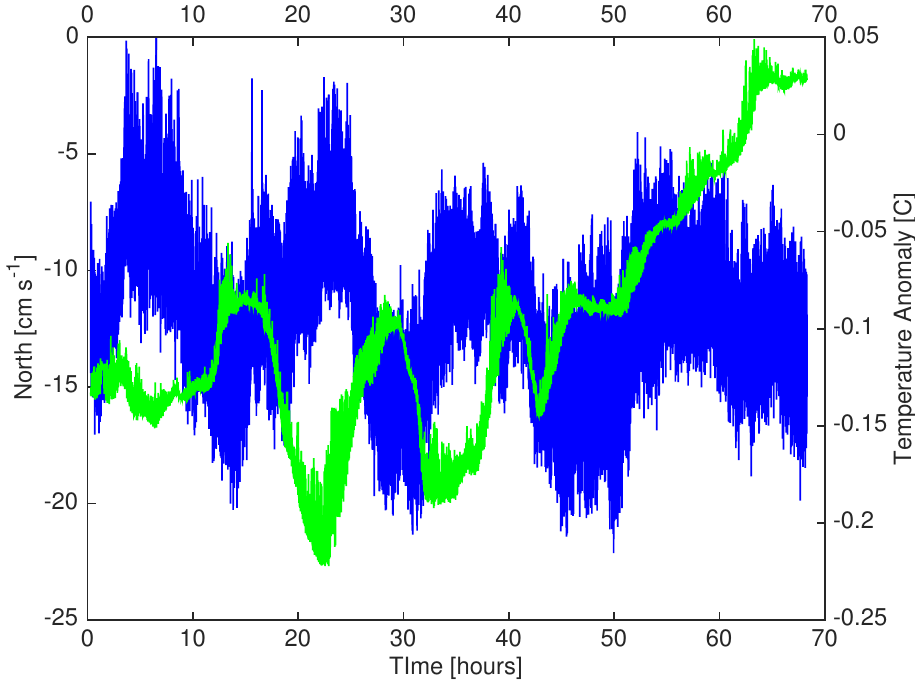
Figure 7. MAVS N/S velocity (blue trace) and RBR temperature (green trace) over the 2.8 day record. The MAVS record has been offset and the temperature record scaled so that the two traces overlay. There is an obvious anti-correlation on internal swash band time